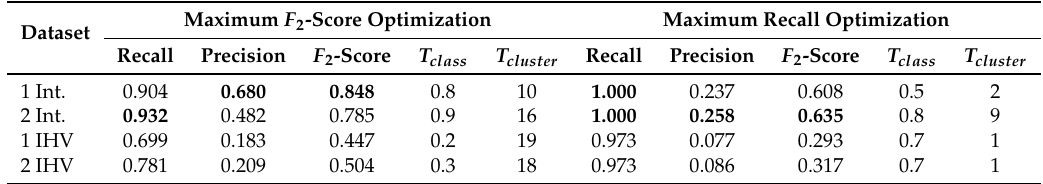
Table 4. Summary of the object detection results (recall, precision and F 2 -score) with the corresponding classification threshold T class and cluster threshold T cluster for the whole public domain. The results and optimal parameters are displayed for both the maximal F 2 -score and maximal recall score. Maximum F 2 -Score Dataset